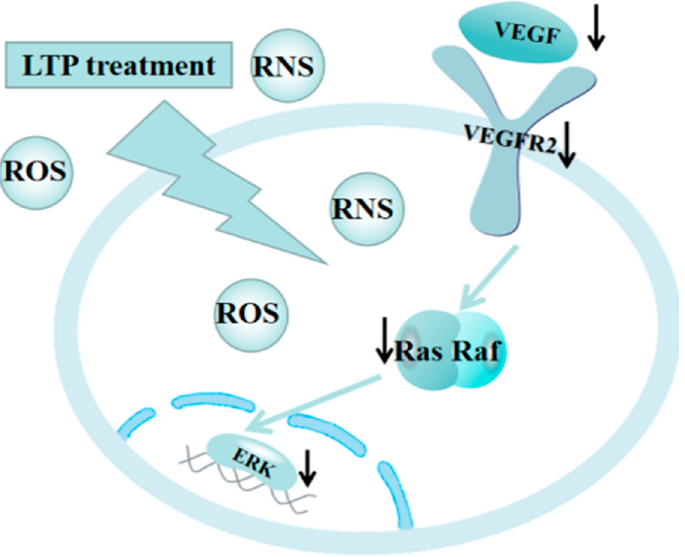
Figure 8. LTP can generate ROS and RNS and suppress the growth of lung cancer cells via inhibition of the VEGF/VEGFR2/RAS/ERK axis. Black arrows in the figure denote proteins with reduced ex- pression following LTP treatment.